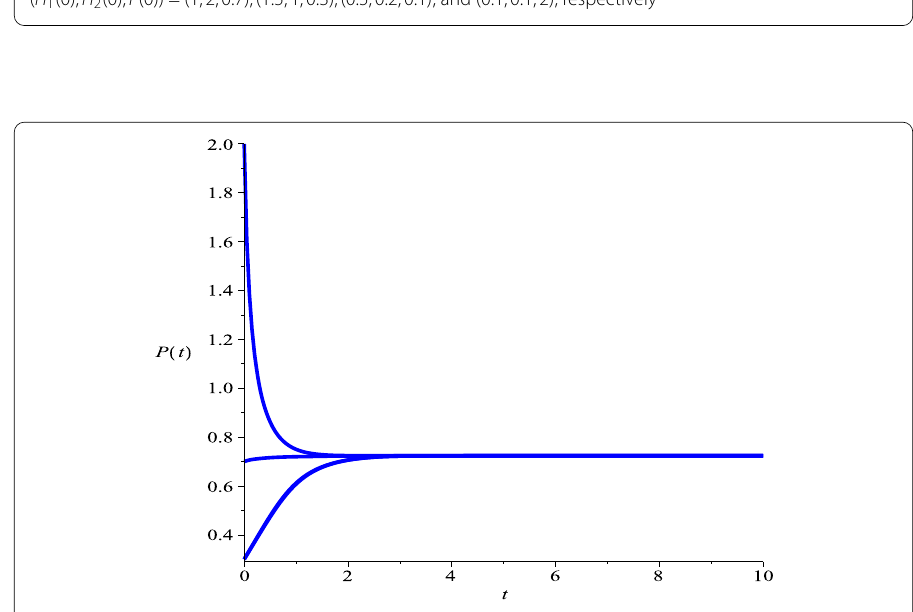
Figure 6 Dynamic behaviors of the second species in system (5.3). The initial conditions ( H 1 (0), H 2 (0), P (0)) = (1,2,0.7),(1.5,1,0.3),(0.5,0.2,0.1), and (0.1,0.1,2), respectively